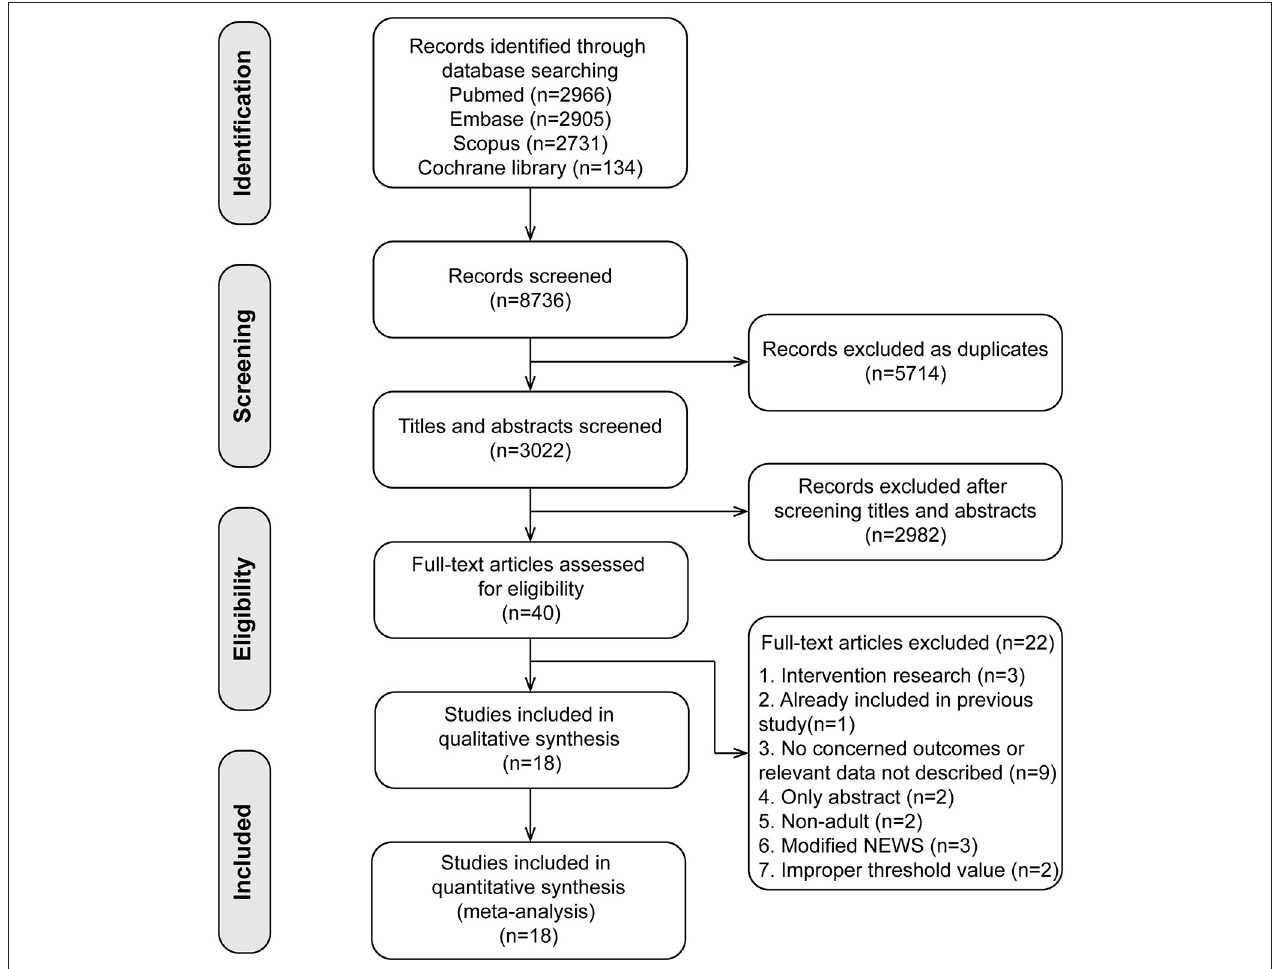
FIGURE 1 | Flow diagram of study